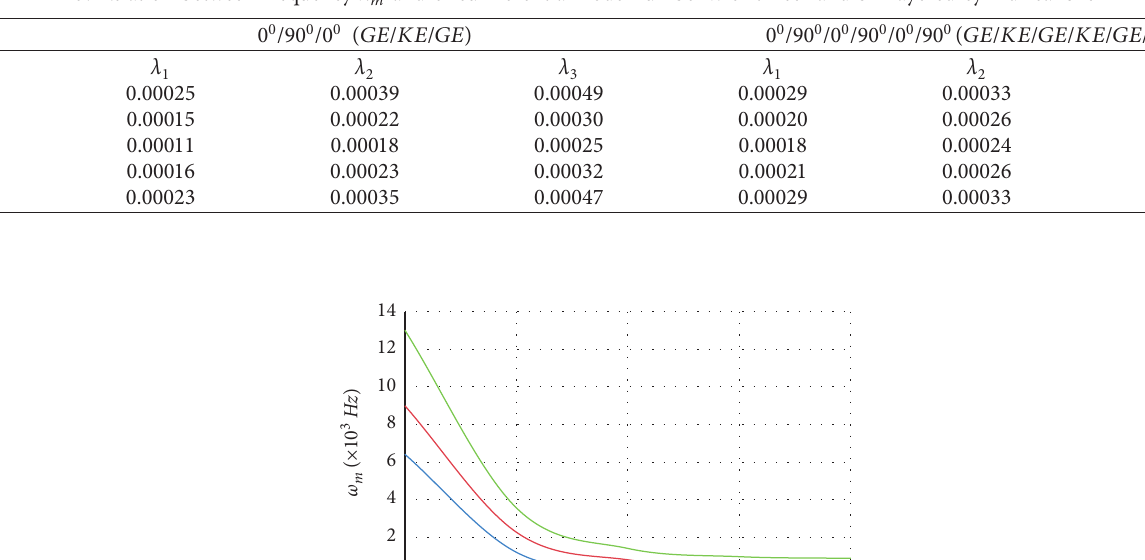
n of three- and six-layered cylindrical shell L � 1 . 5.